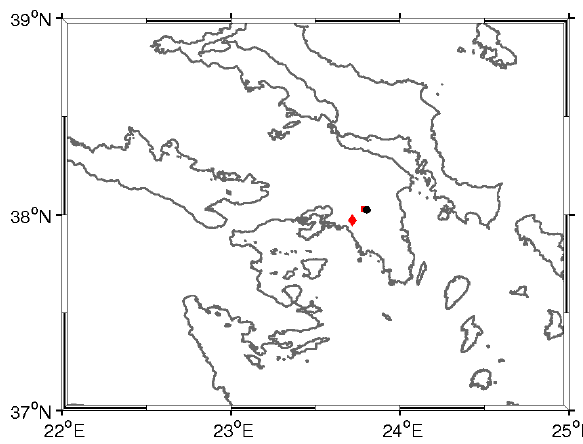
Figure 1. Greater Athens Area including the locations of the Marousi ozone station (red square), the NOA temperature station (red diamond) as well as the location of the RCM closest grid point to the ozone station location (black circle).